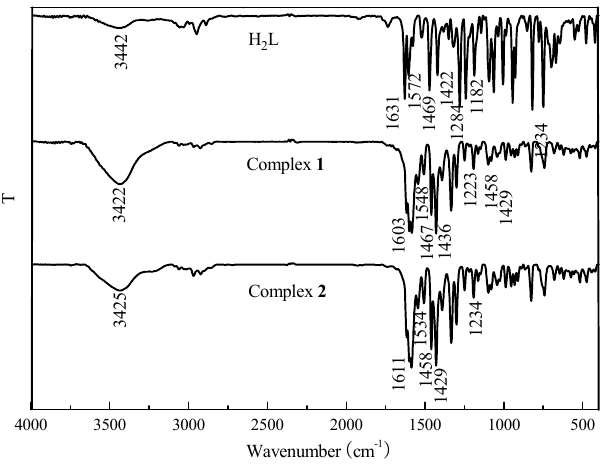
Figure 1. IR spectra of H 2 L and the Co(II) complexes 1 and 2 .